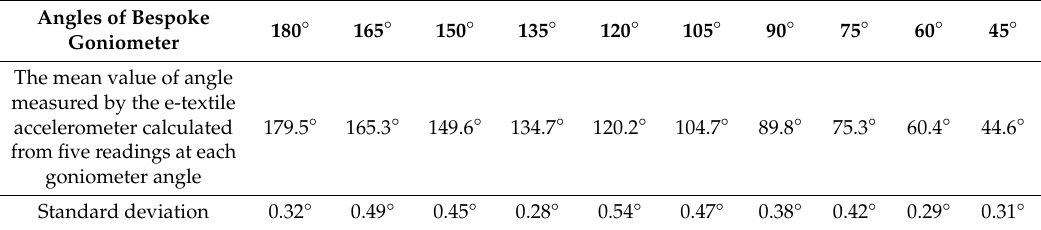
Figure 9. Bespoke goniometer with the e-textile mounted arm to show the verification of joint bending angle. Table 1. Comparison of the e-textile movement sensor’s measured angles and the goniometer position .